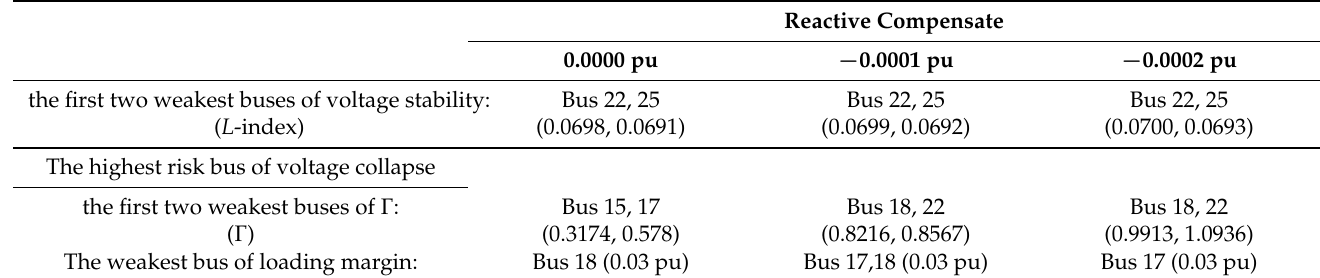
Table 3. Comparisons of first two weakest buses of voltage stability and the most vulnerable bus of voltage collapse on IEEE 33-bus distribution test